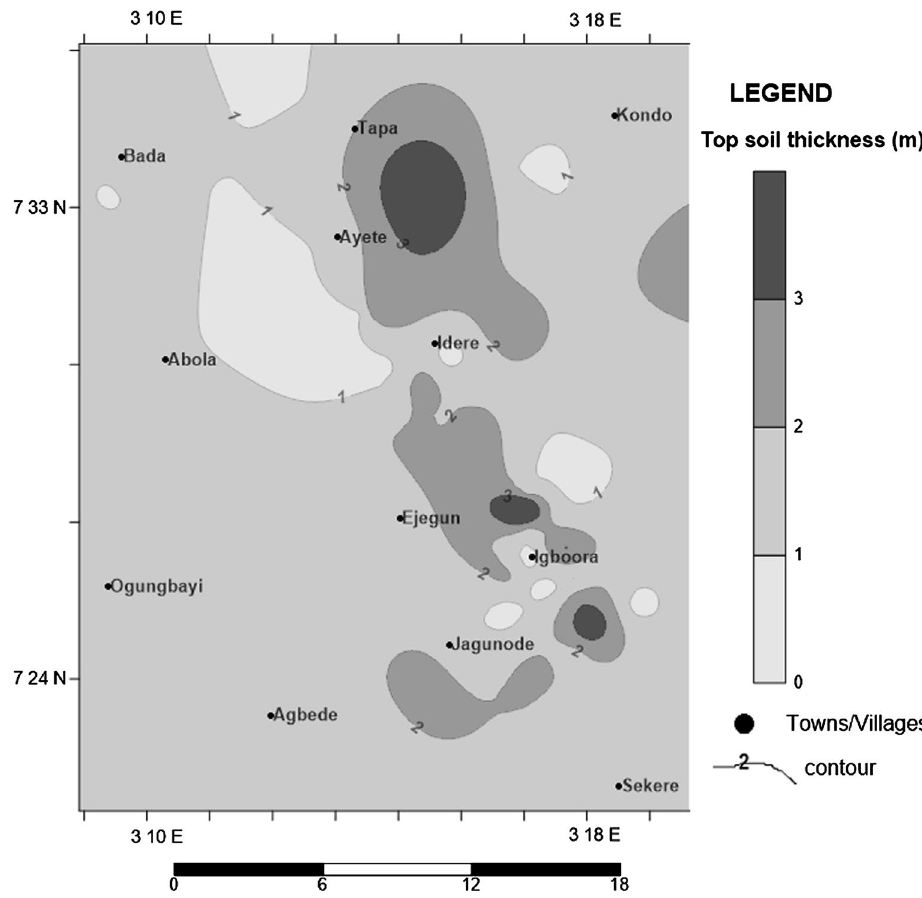
Fig. 6 Topsoil thickness map across the study